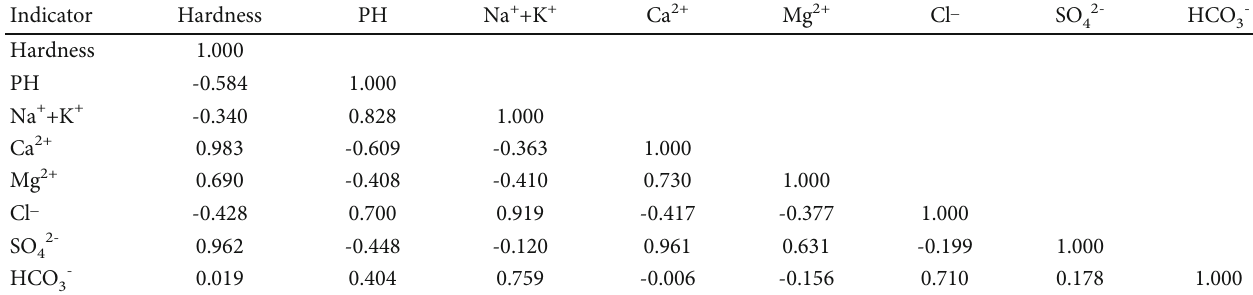
Table 3: Correlation coe ffi cient matrix of chemical